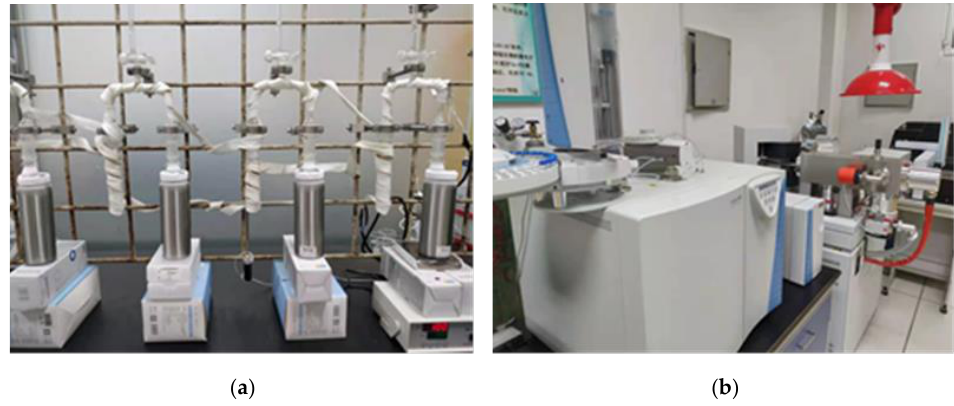
Figure 3. The pictures in the experiment process. ( a ) Moisture extraction equipment; ( b ) Isotope analysis equipment.